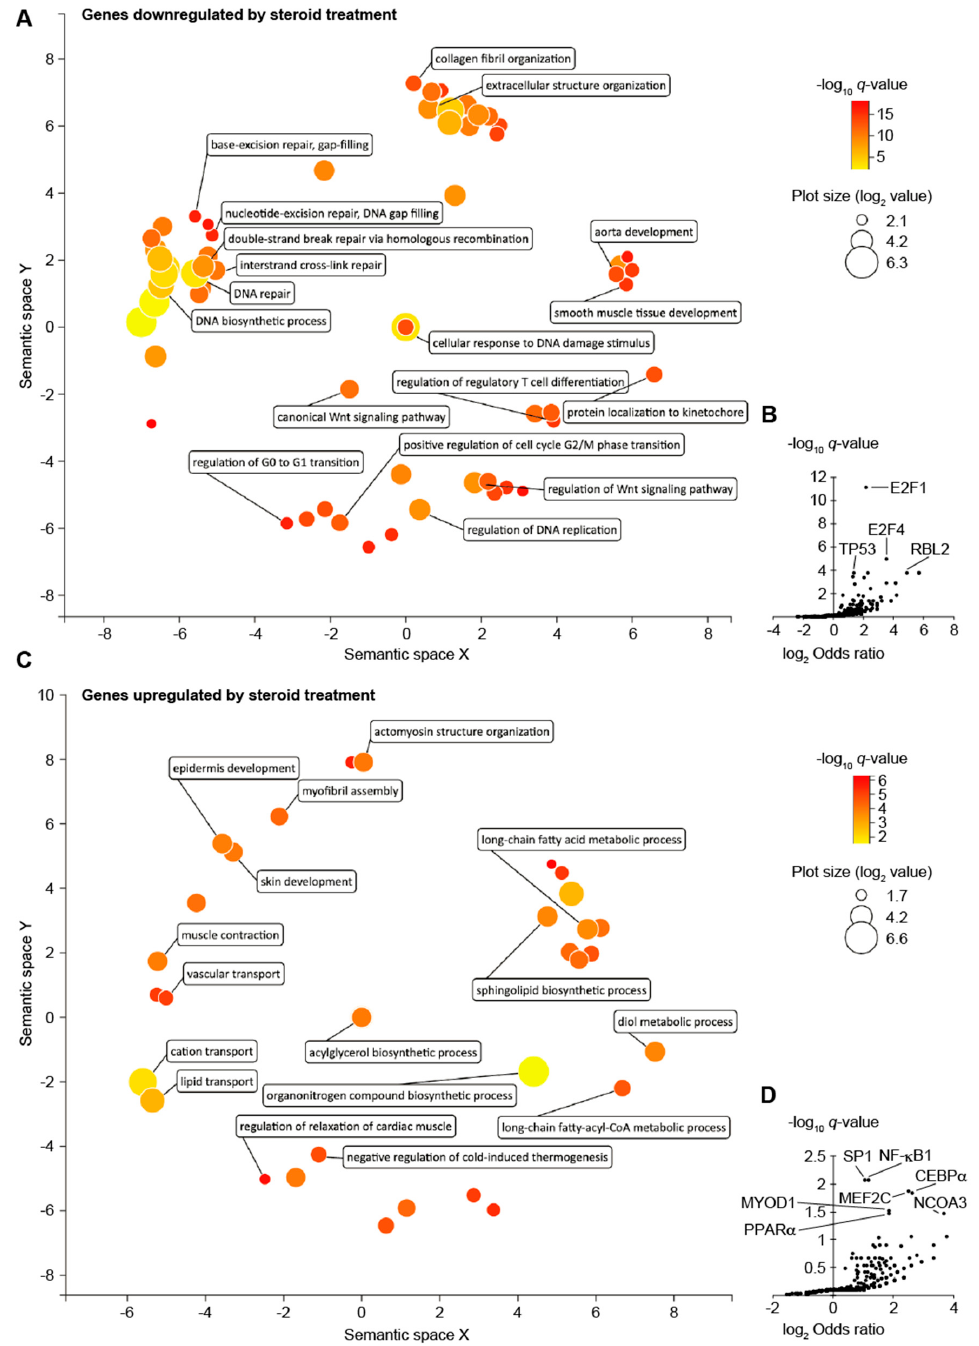
Figure 2. The effects of FA treatment on the transcriptome of the mouse dorsal skin. ( A , C ) GO biological process terms enriched in genes downregulated ( A ) and upregulated ( C ) in the skin 1 day after finishing 12 days of FA treatment. Ontology enrichment analysis was performed using Enrichr, and the results were visualized using REviGO. ( B , D ) Transcription factors (TF) whose target genes were enriched in genes downregulated ( B ) and upregulated ( D ) in the skin 1 day after finishing 12 days of FA treatment. TF target enrichment analysis was performed using TRRUST database and